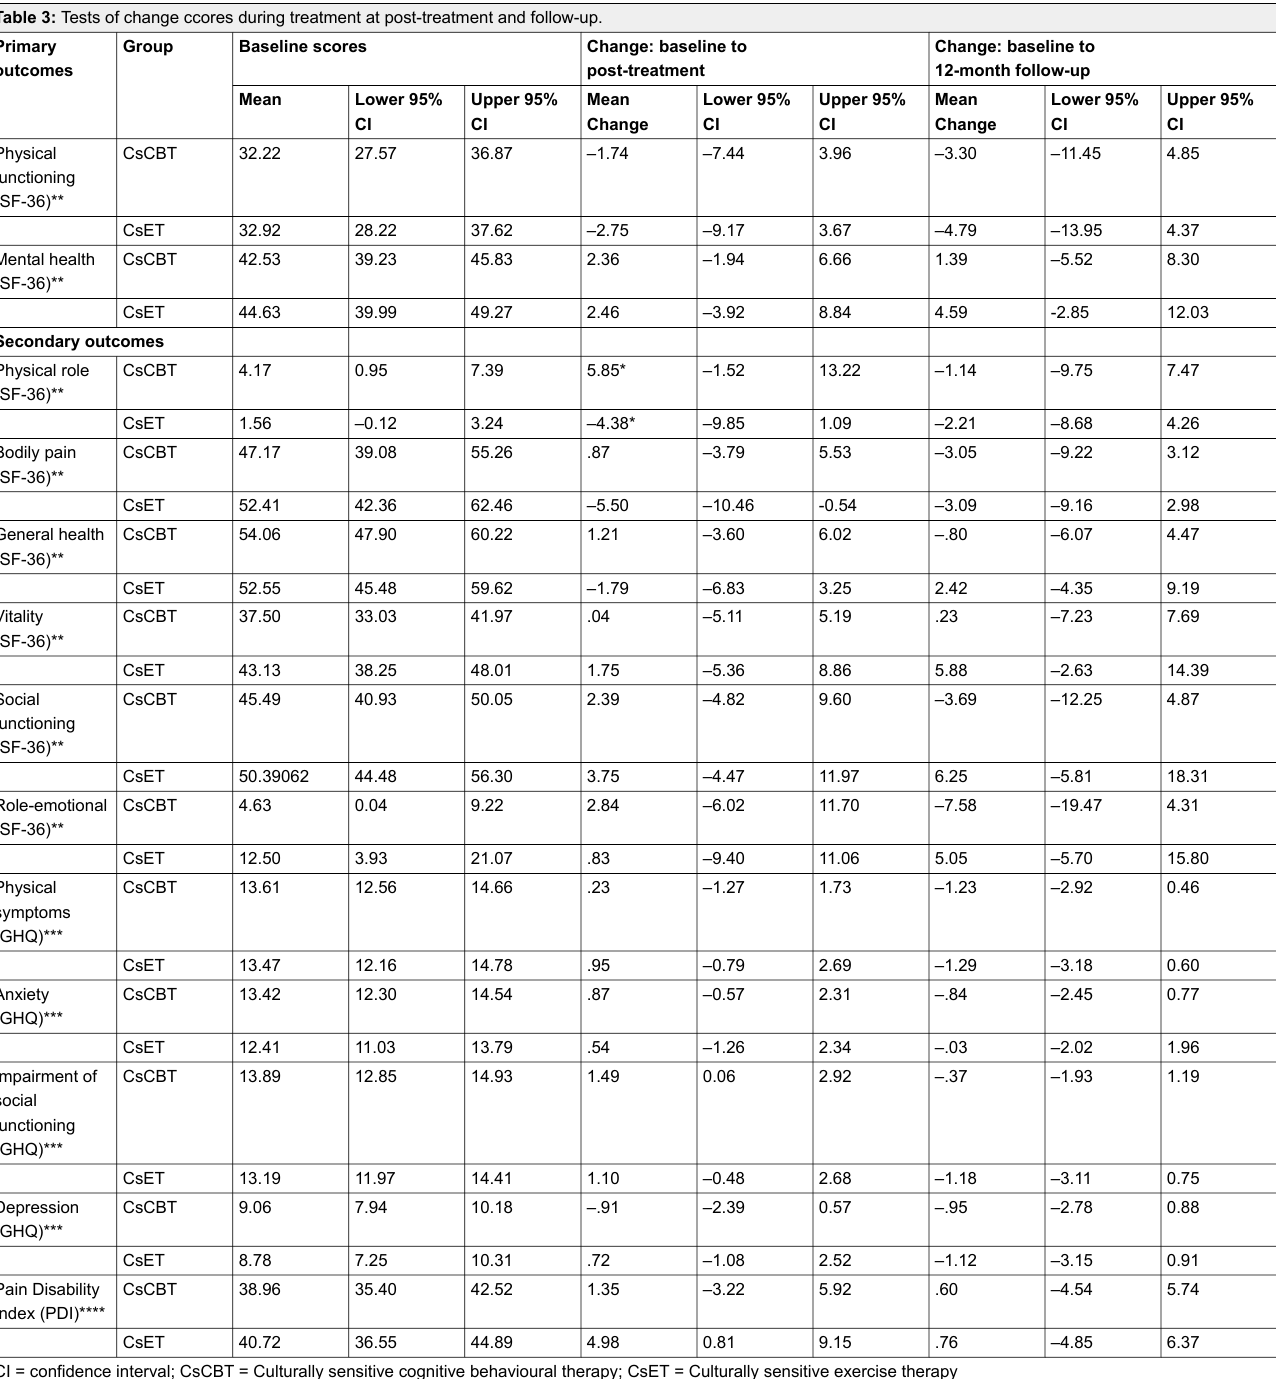
Table 3: Tests of change ccores during treatment at post-treatment and follow-up. Baseline scores